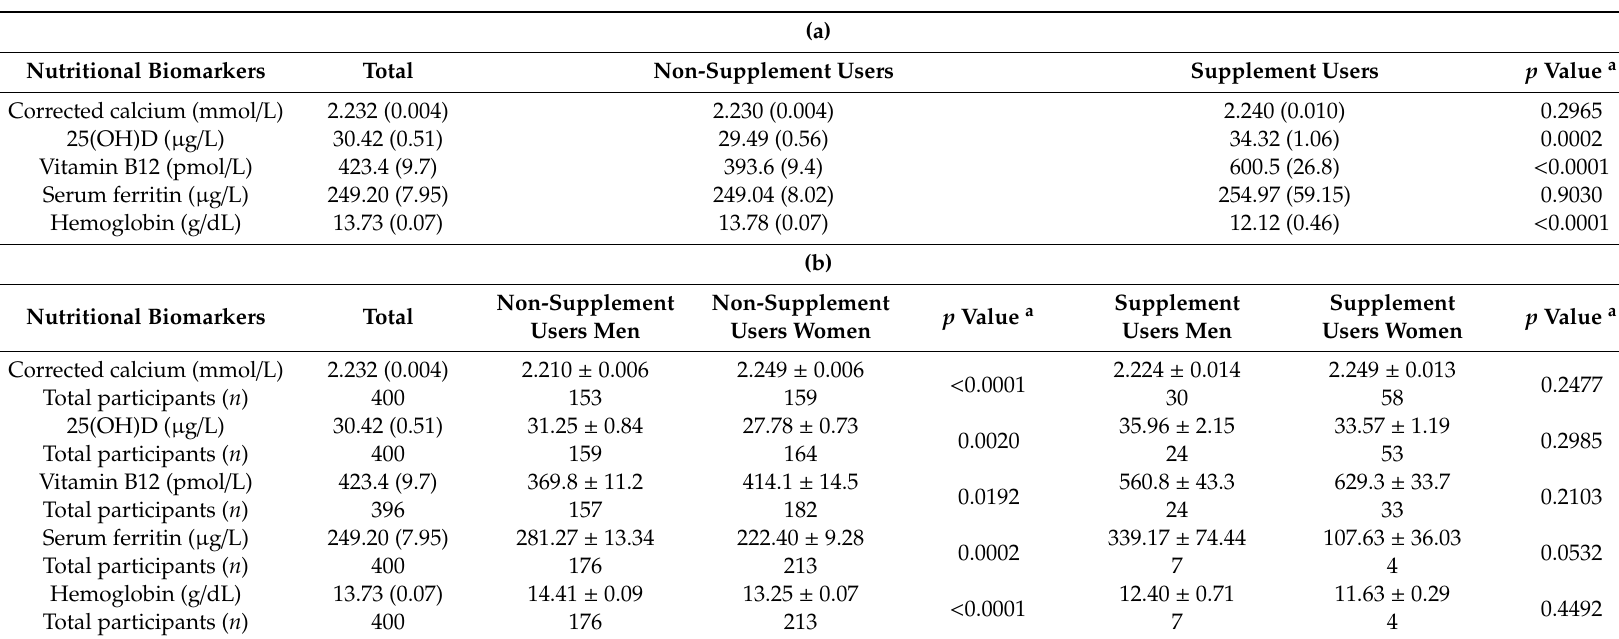
Table 4. a Comparison of nutritional biomarker levels with supplement use. b Comparison of nutritional biomarker levels with supplement use by